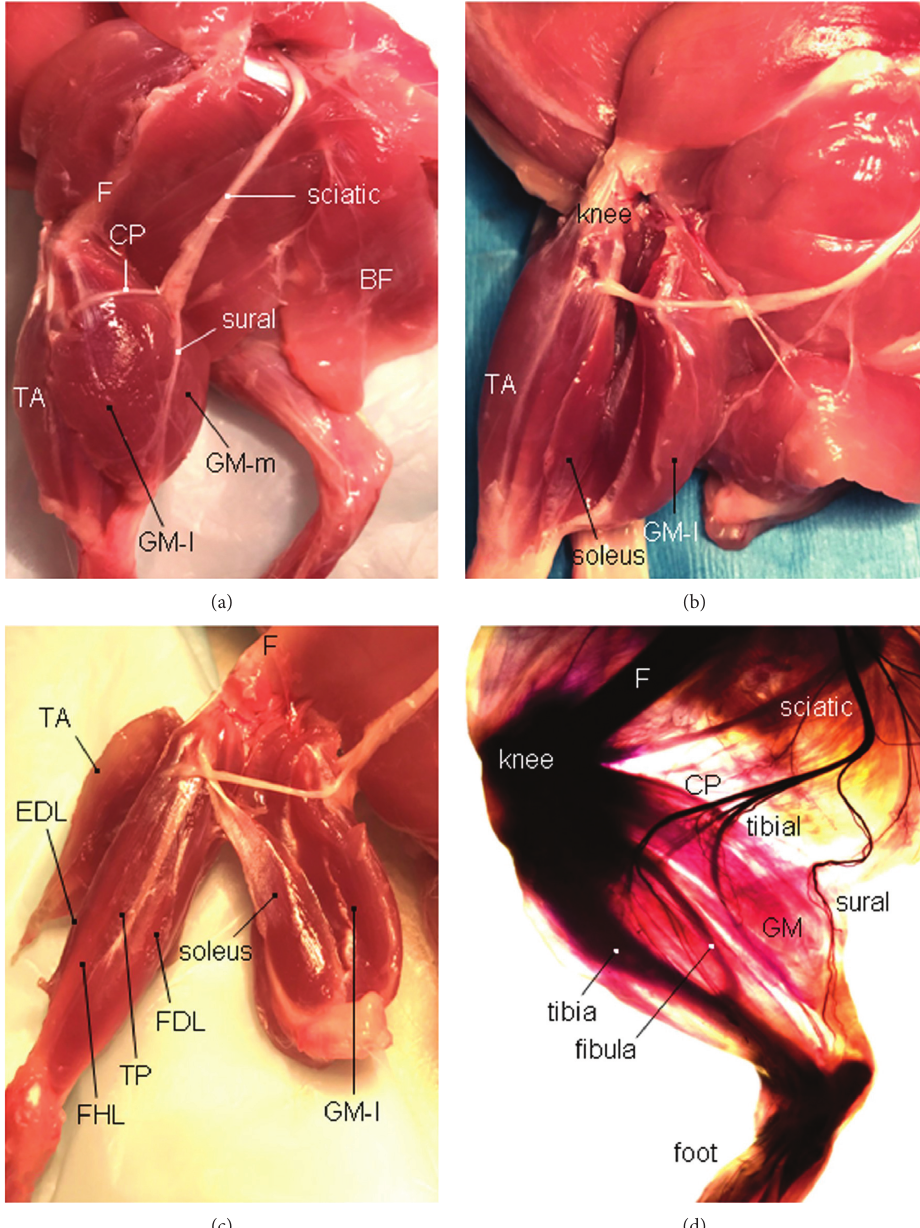
Figure 1: Calf muscles and their innervation of the rat left hind limb. (a) The calf muscle group of the left hind limb is exposed after the biceps femoris (BF) is reflected laterally. CP, common peroneal nerve; F, femur; TA, tibialis anterior muscle; GM-l, lateral compartment of the GM; and GM-m, medial compartment of the GM. (b) Left GM is detached and separated from the soleus muscle. (c) The separated calf muscles, including GM, soleus, flexor digitorum longus (FDL), flexor hallucis longus (FHL), and tibialis posterior (TP) muscle innervated by the tibial nerve, as well as the TA and extensor digitorum longus (EDL) innervated by the deep peroneal nerve. F, femur. (d) A rat left hind limb processed with Sihler’s stain without microdissection, showing anatomical relationships among calf muscles, innervating nerves, and bone